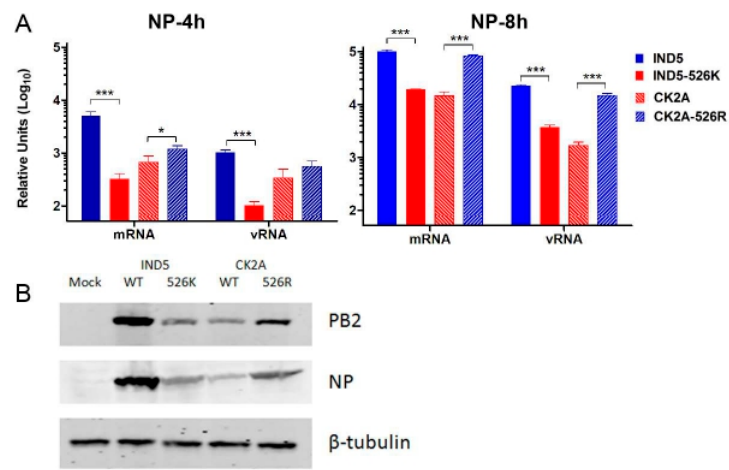
Figure 4. Effect of PB2 526R on H5N1 viral RNA and protein synthesis. ( A ) A549 cells were infected with reverse genetic wild type IND5 or CK2A H5N1 viruses or mutant versions of these viruses containing either 526K or 526R PB2, respectively, at an MOI of 1. Total RNA was extracted at 4 or 8 h post infection and reverse transcription (RT) performed using uni-12 or oligo dT primers, to detect vRNA or mRNA, respectively. Expression of these two RNA species of NP was quantified by relative quantitative real time RT-PCR and normalized against the β -actin gene. Data represent mean relative NP expression levels from three independent experiments. Statistical significance was analyzed by one-way ANOVA, corrected by the Bonferroni post test: *** p < 0.001and * p < 0.05. ( B ) A549 cells were infected as above. Cells were lysed at 8 h post infection and expression levels of NP and PB2 estimated by Western blot using anti-NP (1:5000) and anti-PB2 (1:1000) antibodies. Expression levels of β -tubulin were detected using anti- β -tubulin antibody, and served as a loading control.